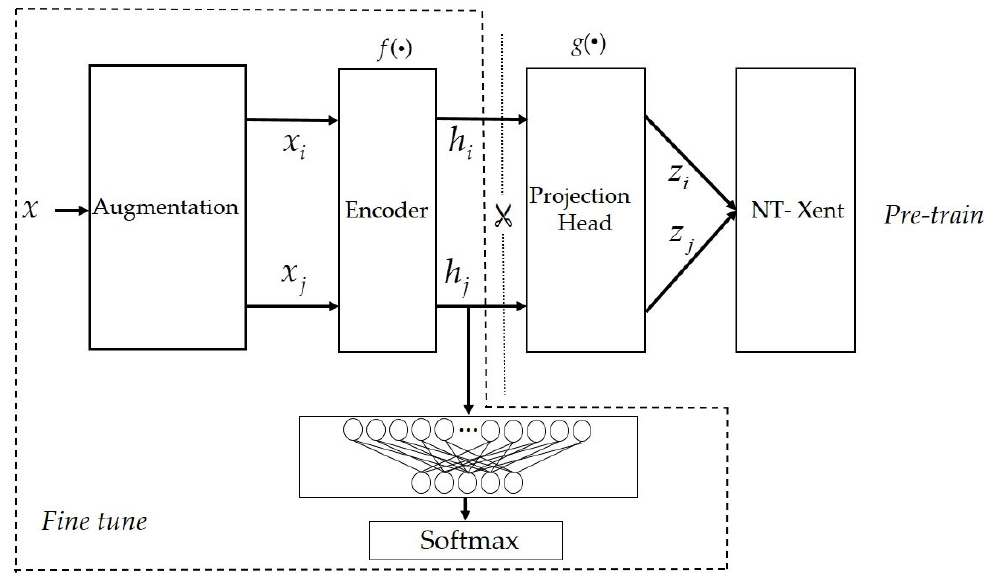
Figure 1. The framework of